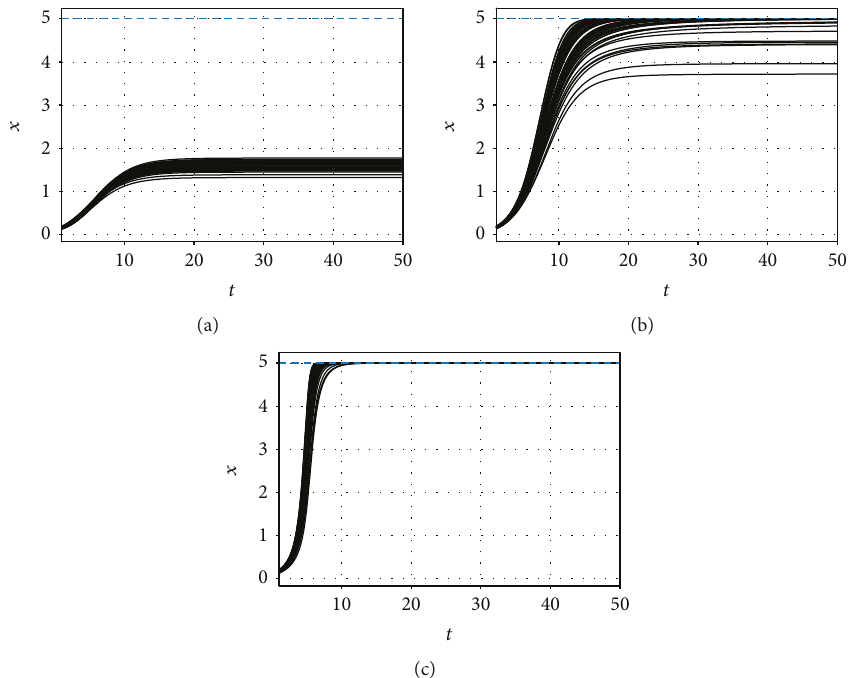
Figure 5: Temporal evolution of all variables in the case of model A, described in (3), for increasing values of the links ’ weight: w = 0 01 (a), w = 0 025 (b), and w = 0 05 (c). The system is attracted to one of the three possible global stable states, depending on both the parameters of the dynamic model and the topology: metric stable state, x W (a), mixed stable state (b), and optimal stable state (c). All plots are d represented for an ER network with 50 nodes and edge probability p = 0 4 . Parameters are equally set to C = 5 , r = 0 5 , K = 1 0 for all